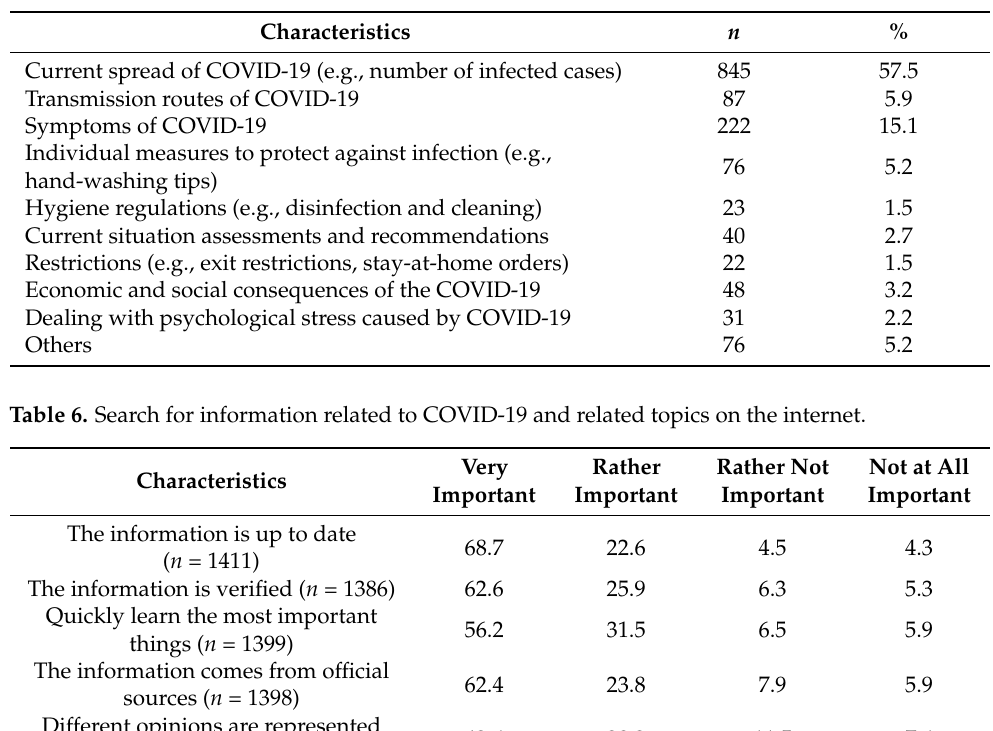
Table 5. Specific topics searched for in the context of COVID-19 ( n = 1470).